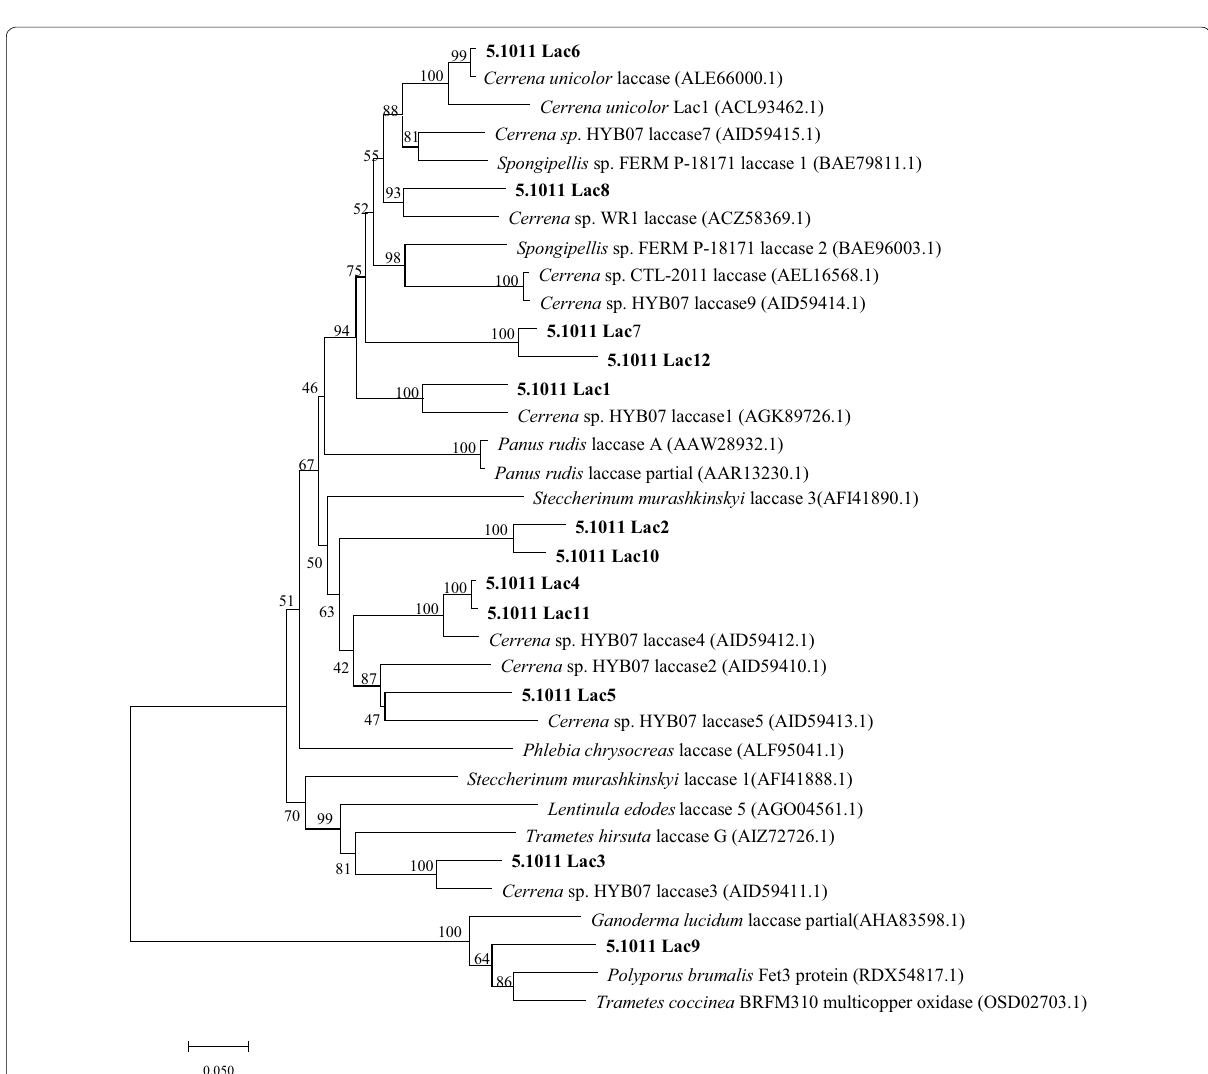
Fig. 2 Phylogenetic relationship of C. unicolor CGMCC 5.1011 laccases with reported laccases. The scale bar indicates the estimated number of amino acid substitutions per